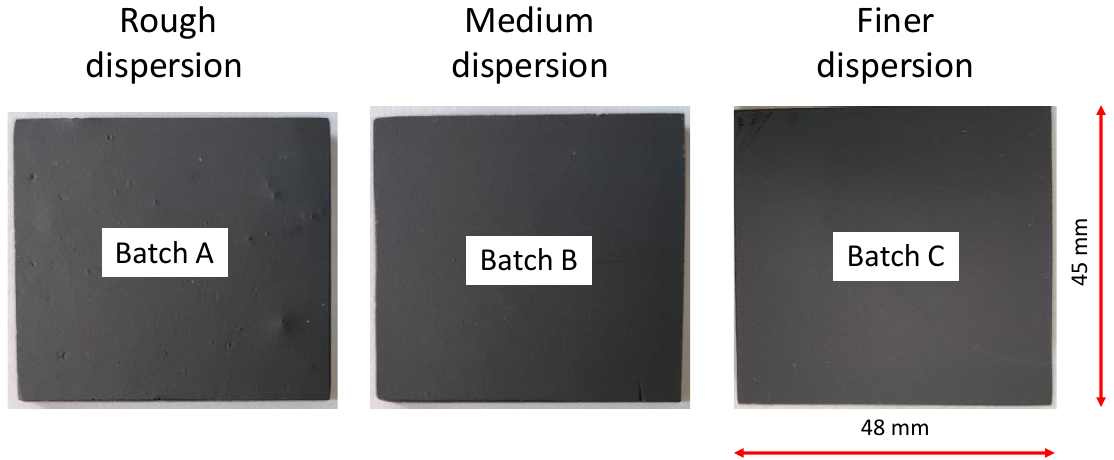
Figure 2. Image of three samples from each batch after applying the matte black paint. Table 2. Thermal properties of the materials.